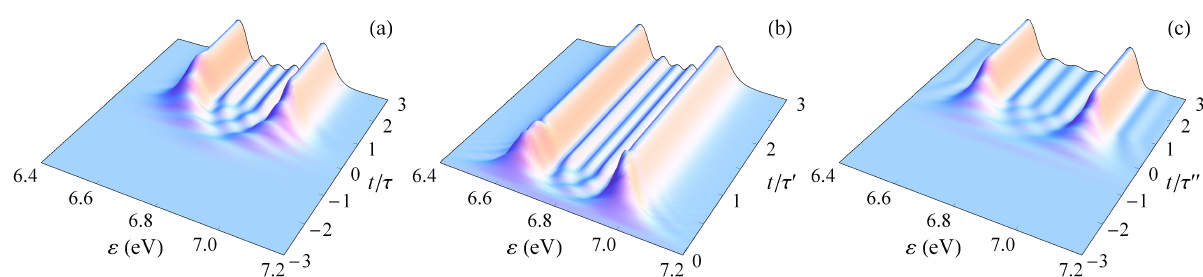
Figure 4. (Color online) Time evolution of the photoelectron energy distribution (in arbitrary units) during the photoionization process of the hydrogen atom by: ( a ) Gaussian pulse (7), ( b ) half-Gaussian pulse (8) and ( c ) rectangular pulse (9) of carrier frequency ω = 0.375a.u. and peak intensity of 12.917TW/cm 2 at which the atom completes five Rabi cycles during the pulse.